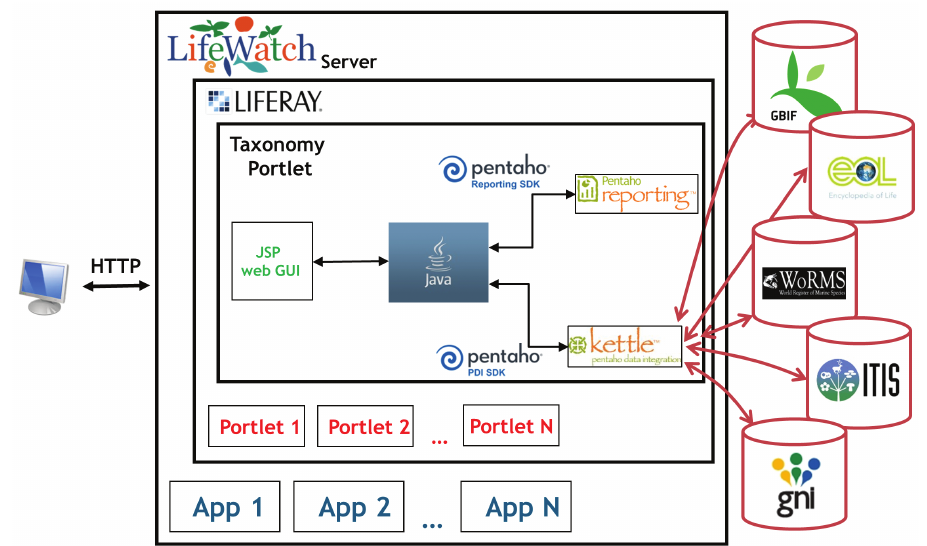
Figure 3. Implementation of the service with the used